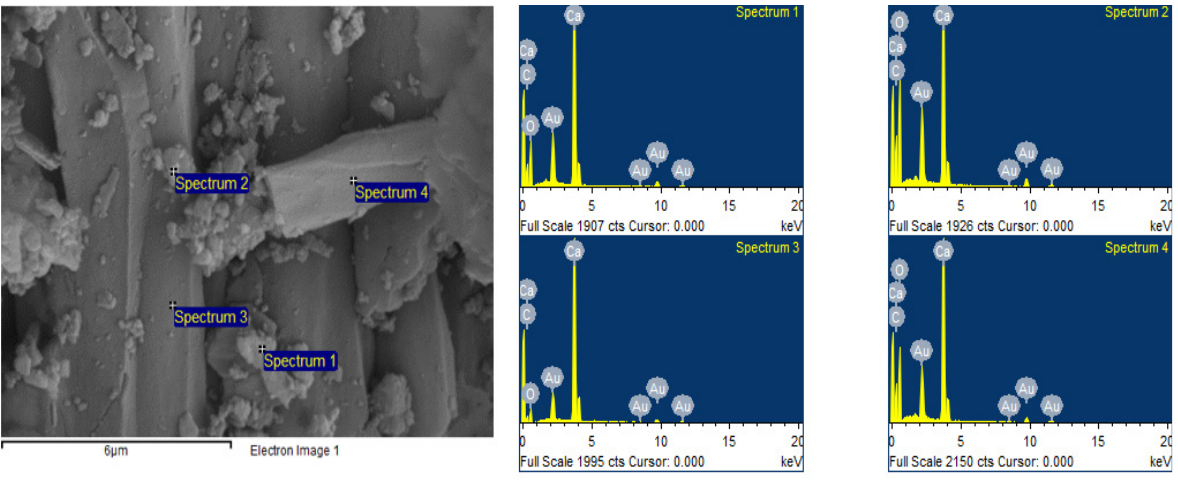
Figure 3. Scanning electron micrograph and EDAX spectrum of WS.